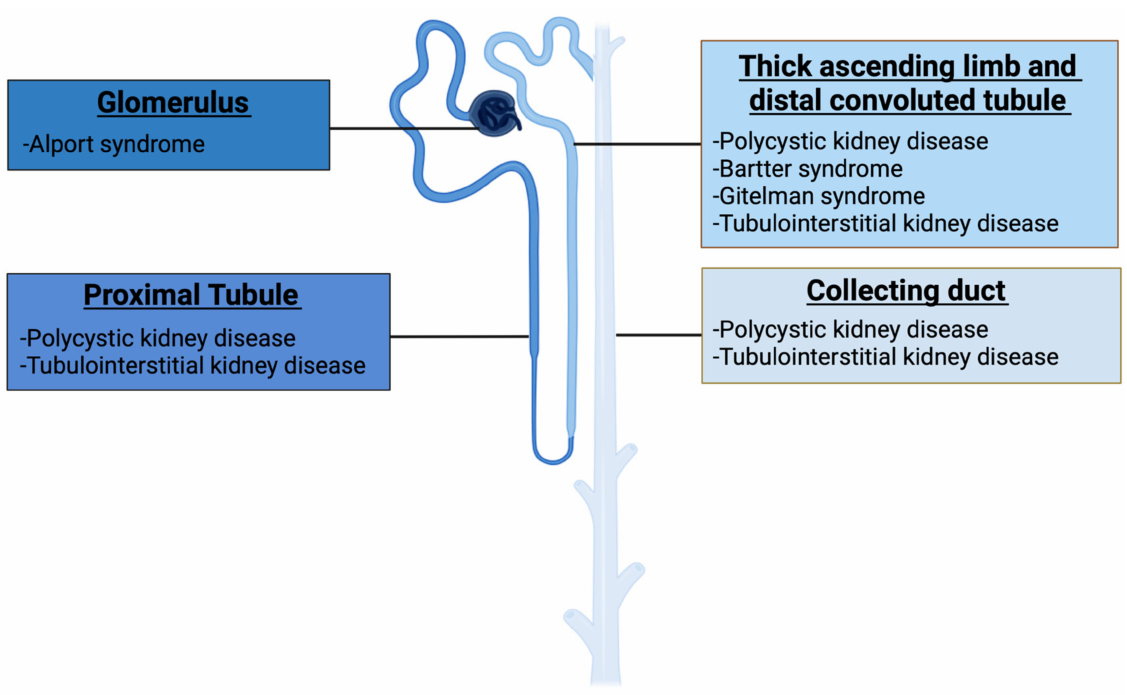
Figure 1. Representation of the nephron and selection of Genetic kidney diseases. Diseases are arranged and categorized according to the predominant localization and manifestation of the defect within the